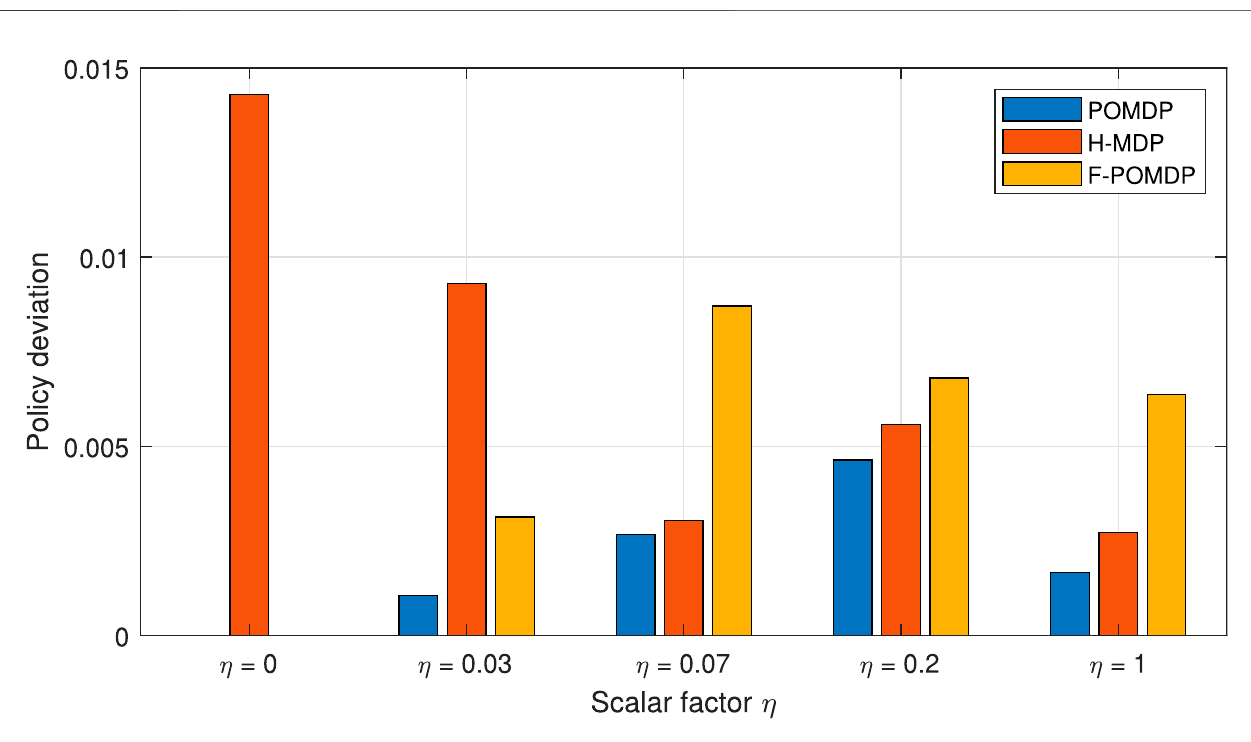
FIGURE 9 | Deviation from the optimal MDP policy of full observability.